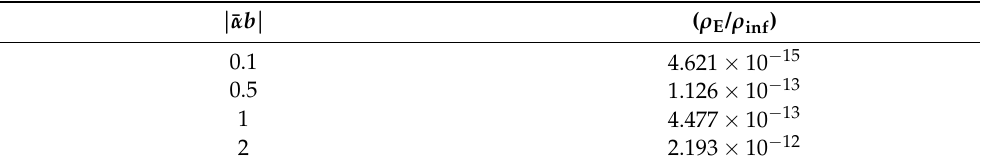
Table 2. The numerical estimations of the ratio ρ E / ρ inf is being presented for different choices of the parameter ¯ α b , where ρ E being the energy density in the electric field and ρ inf being the energy density of the inflationary field. As evident for smaller values of the parameter | ¯ α b | the ratio is smaller and hence back reaction effects are